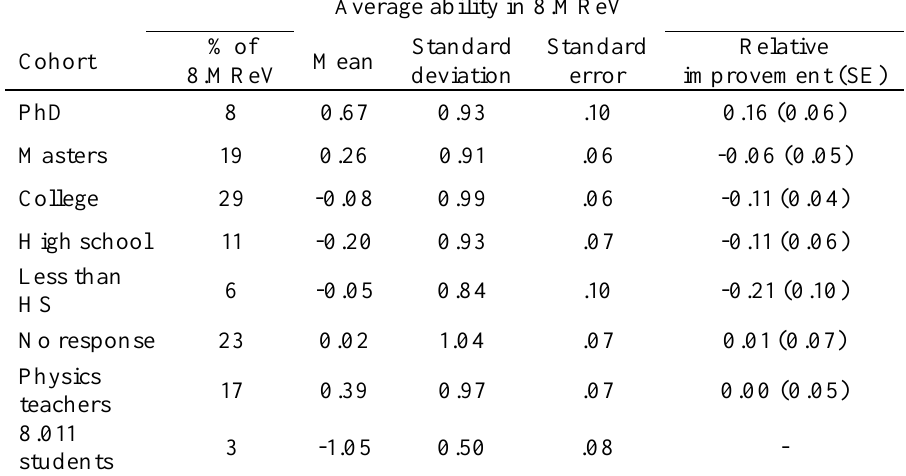
Average ability in